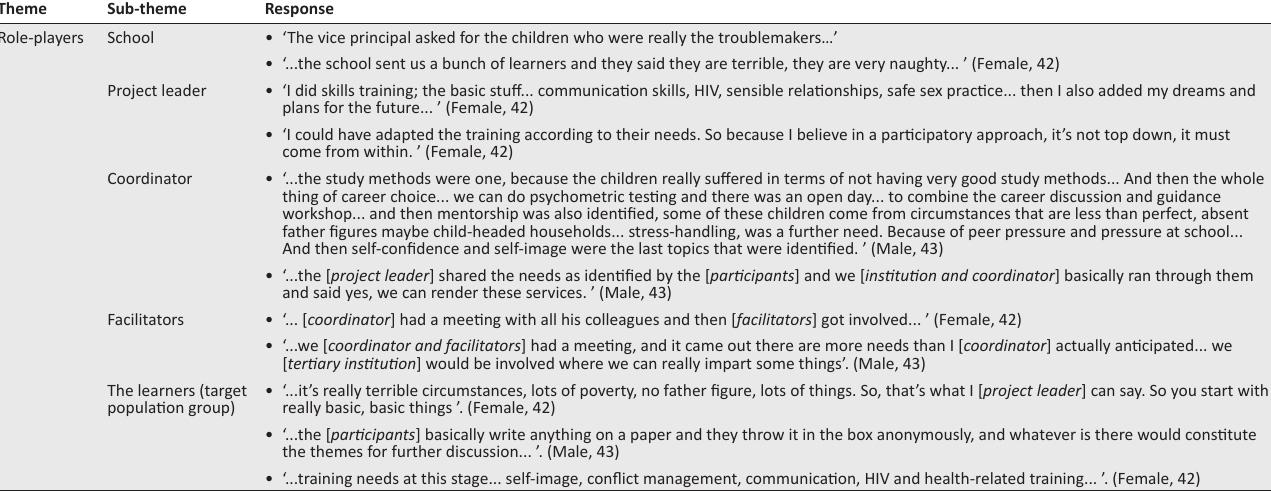
FIGURE 1: Overview of categories. TABLE 2: Needs